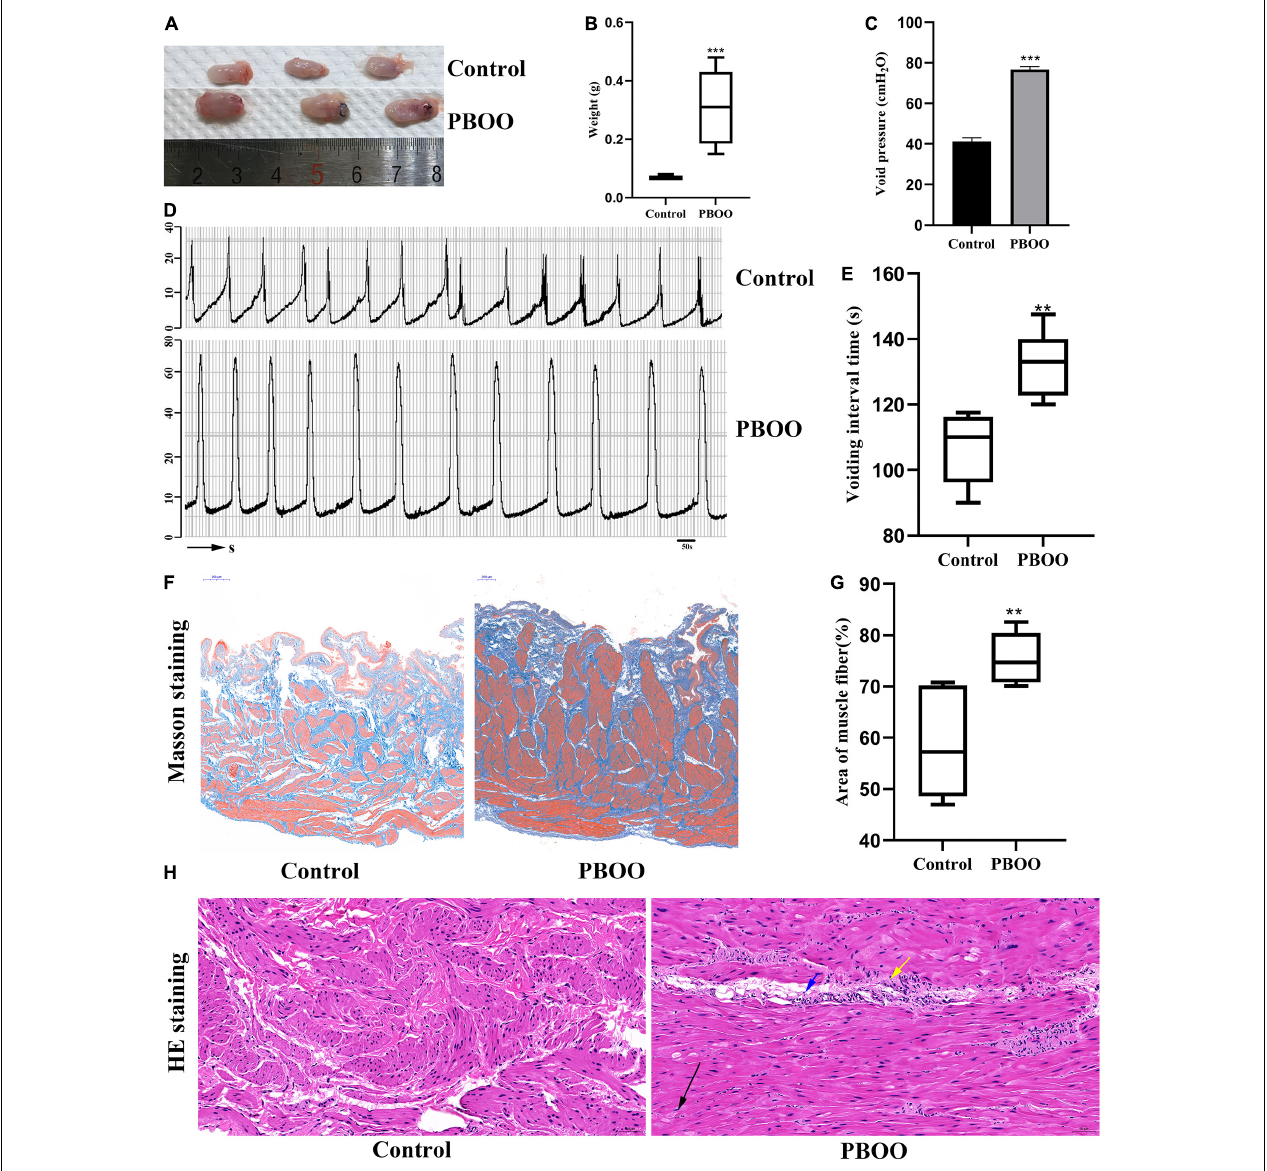
FIGURE 1 | Construction of bladder partial outlet obstruction (PBOO) model in rat. Bladder shape (A) was bigger and weight (B) was higher in rat of PBOO compared with control group. Cystometric evaluation (D) indicated higher voiding pressure (C) and lower voiding frequency (E) compared with control group. Masson staining of bladder tissue show hypertrophy muscle fiber (F) and lower area of collagen fiber (G) in PBOO rat. HE staining of bladder tissue demonstrated local muscle fiber swelling (H) , cytoplasmic looseness (black arrow), occasional granular mast cells (yellow arrow), and a small number of neutrophils in the blood vessels (blue arrow). * P < 0.05, ** P < 0.01, *** P <